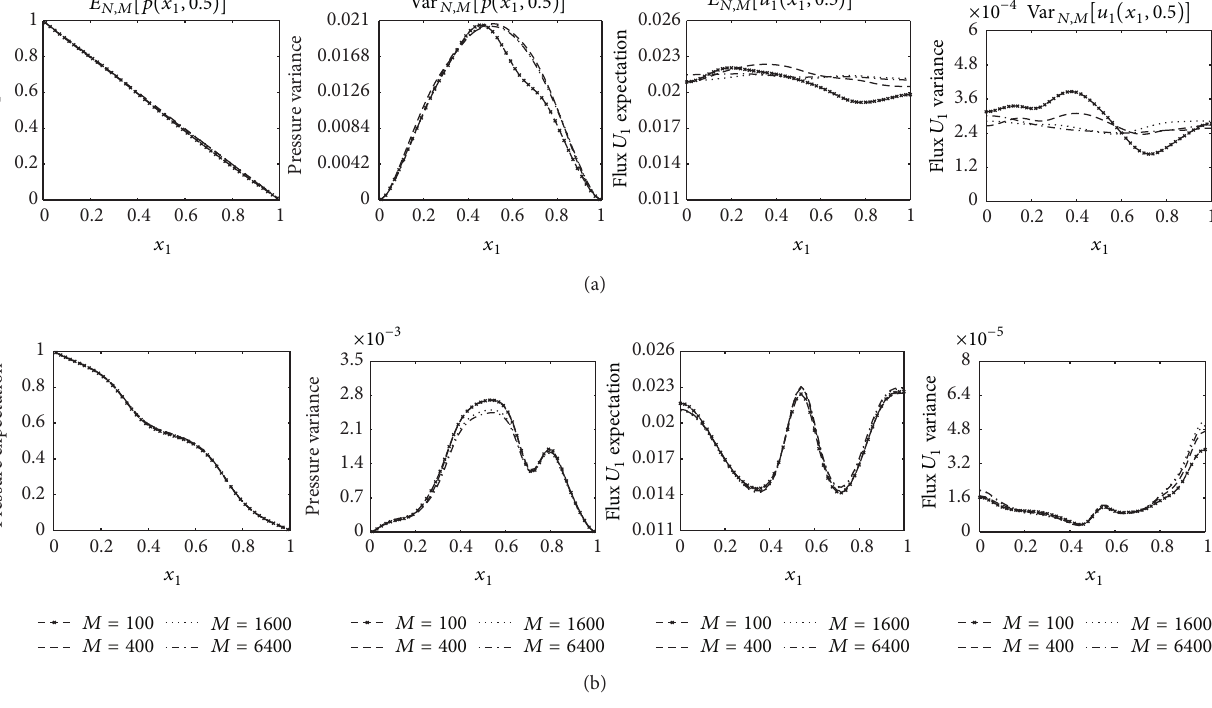
Figure 7: Profiles obtained with KL-MC of moments of pressures and fluxes for unconditional field 𝑁 𝑚 = 0 (a) and conditional field with = 30 𝑁 𝑚